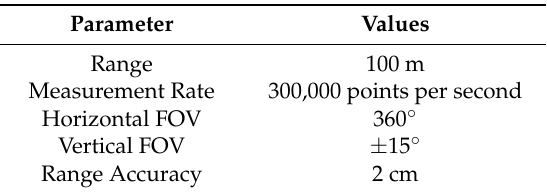
Table 3. Specific parameter description of